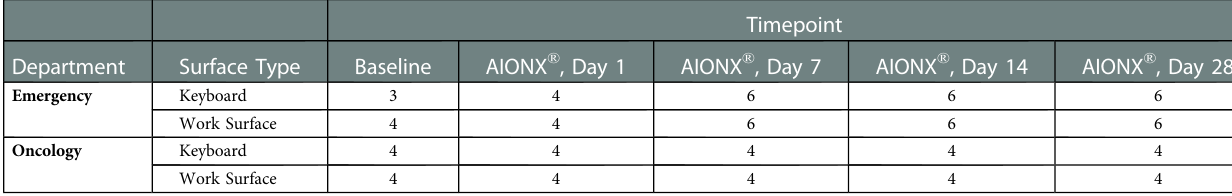
TABLE 1 Summary of samples that were included in downstream bioinformatic analysis after quality fi